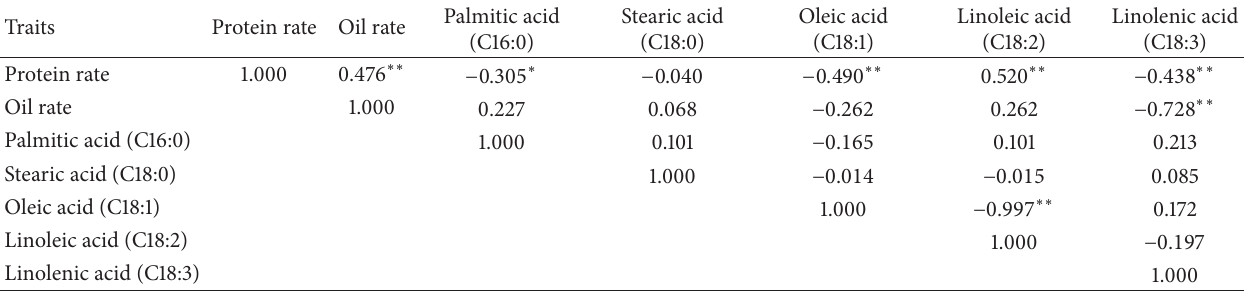
Table 5: Correlation coefficients among protein, oil, and fatty acid composition of safflower seeds.